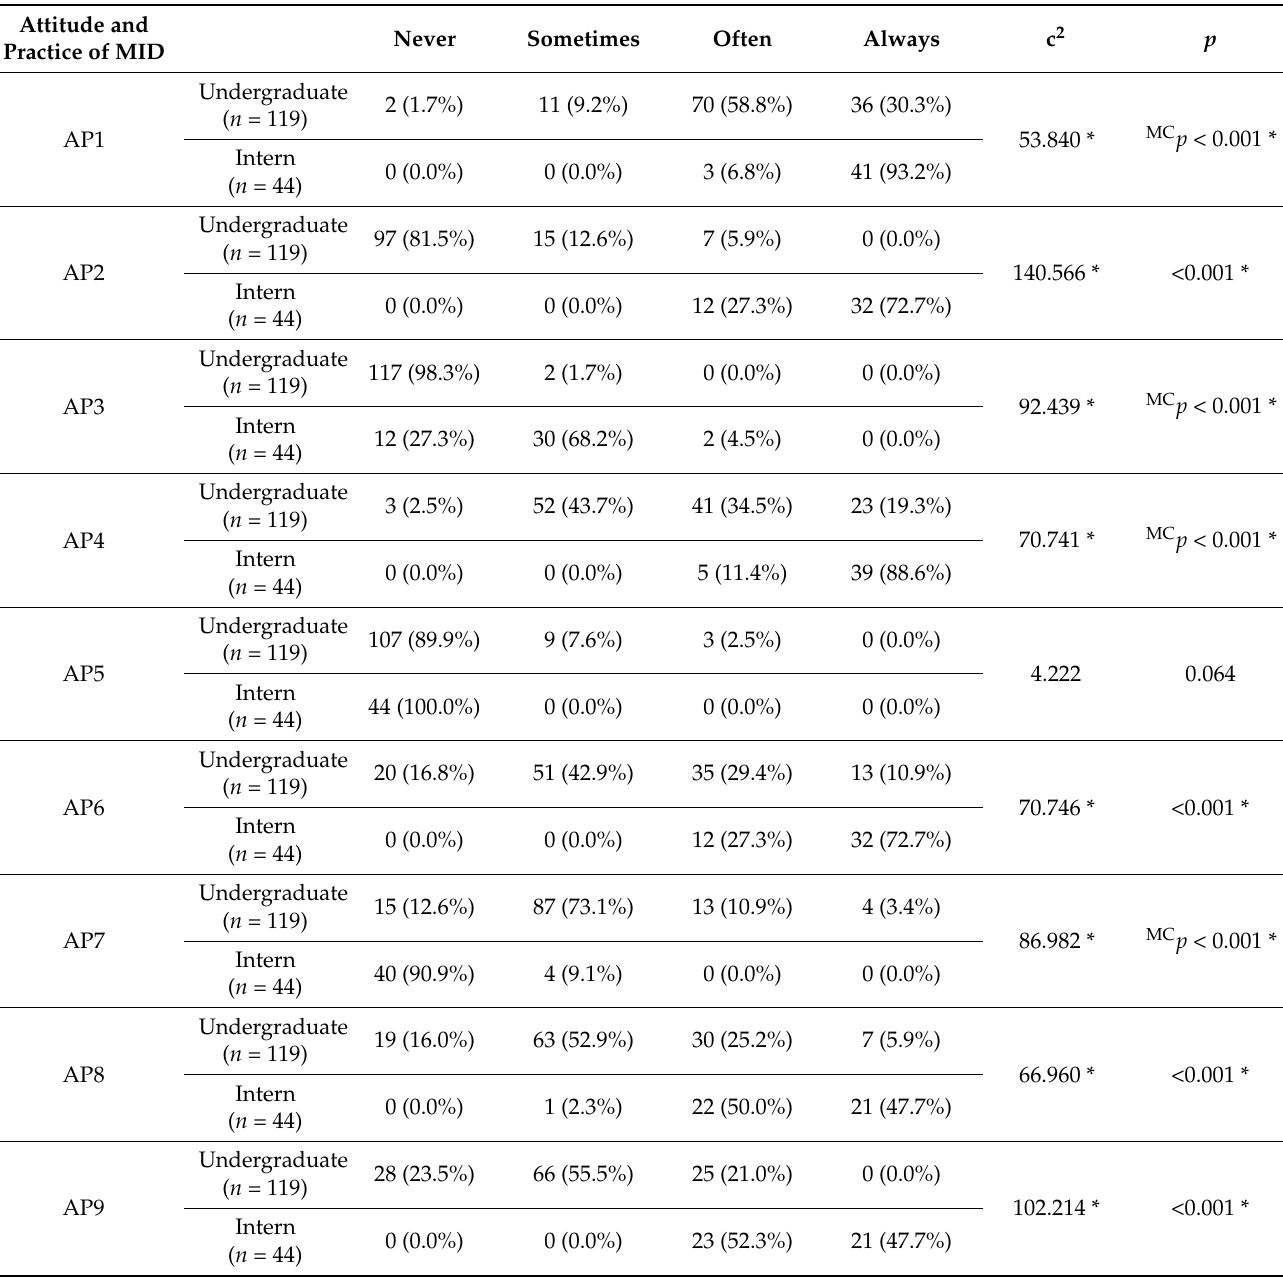
c 2 : Chi-square test. MC : Monte Carlo. p : p -value for comparing between the studied groups. *: Statistically significant at p ≤ 0.05. On finalizing the total available data and giving scores to the responses of both groups, we also realized that there is a significant difference in the scoring value of attitude